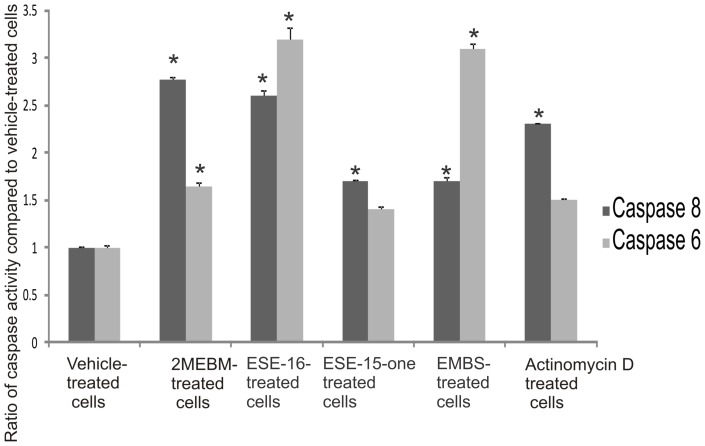
Determination of caspase activation.Caspase 8 and caspase 6 activity ratios of compound- and actinomycin D-treated cells compared to vehicle-treated cells. Caspase 6 and caspase 8 activities in all compound-treated cells increased when compared to vehicle-treated cells. EMBS-treated cells demonstrated the most prominent increase in caspase 8 activity and ESE-16-treated cells the most prominent increase in caspase 6 activity when compared to vehicle-treated cells. 2-Methoxyestradiol-bis-sulphamate-treated cells are illustrated in the figure as 2MEBM due to limited space. An asterisk (*) indicates a statistically significant P-value of <0.05 when compared to vehicle-treated cells.